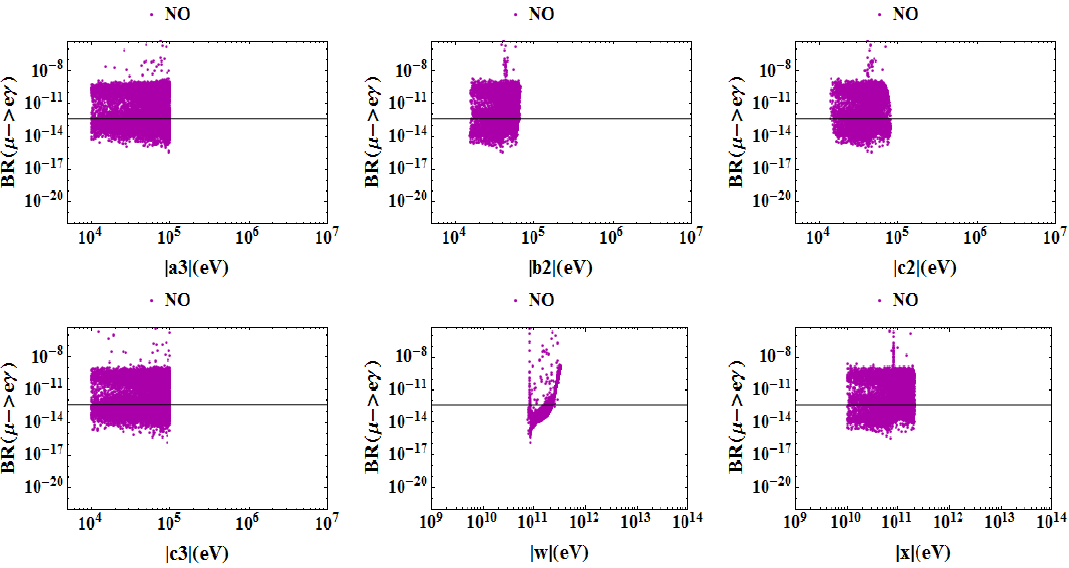
Figure 25 . BR for (cid:22) ! e (cid:13) as a function of model parameters for the class A1. The horizontal line represents the upper limit for BR given by MEG